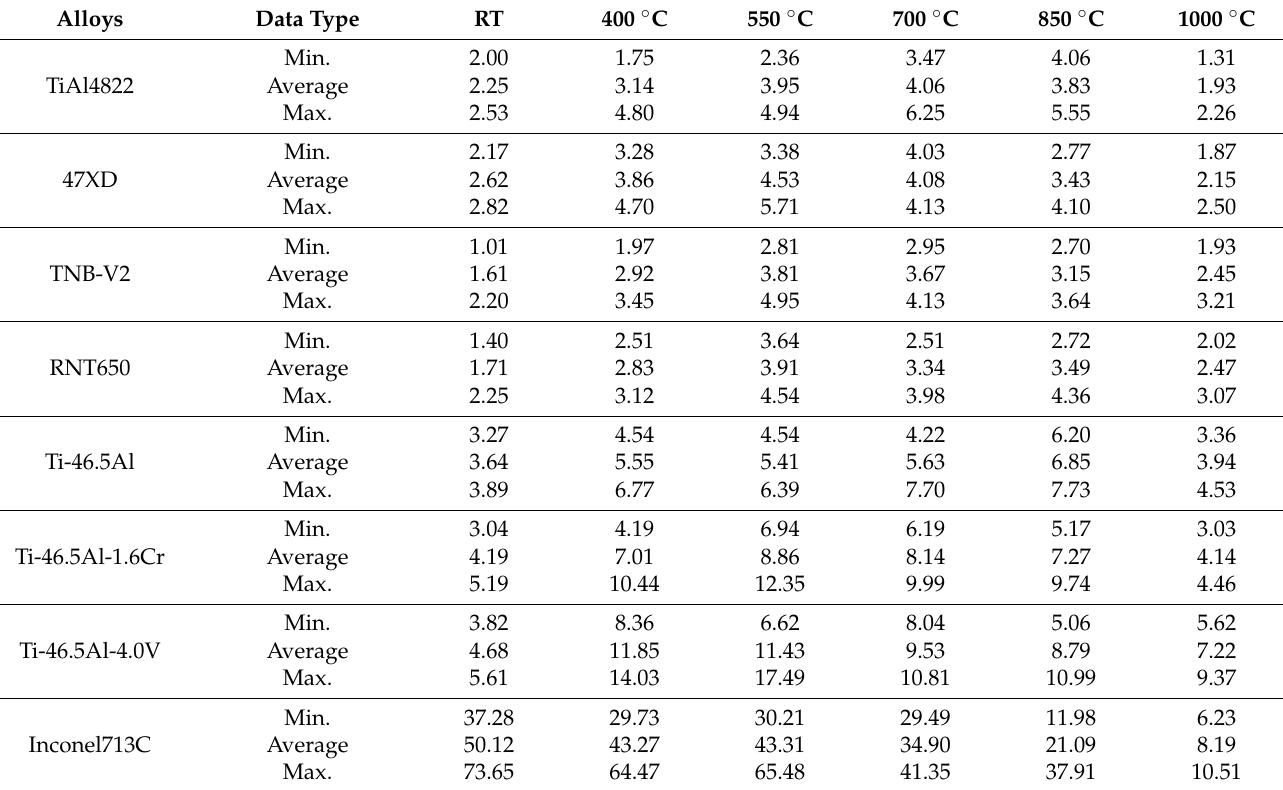
Figure 4. Backscattered electron images showing the microstructure of TiAl forged alloy: ( a ) TNM alloy; ( b ) Ti-44.0Al-3.1Cr isothermally forged and heat treated at 1230 ◦ C for 1 h, followed by air cooling, and heat treatment at 850 ◦ C for 6 h, followed by furnace cooling; ( c ) Ti-42Al-5Mn; ( d ) Ti- 42.0Al-3.4Cr, hot-forged and heat treated at 1200 ◦ C for 2 h, followed by furnace cooling. Table 1. Charpy absorbed energies of cast TiAl alloys and Inconel 713C at various temperatures (J/cm 2